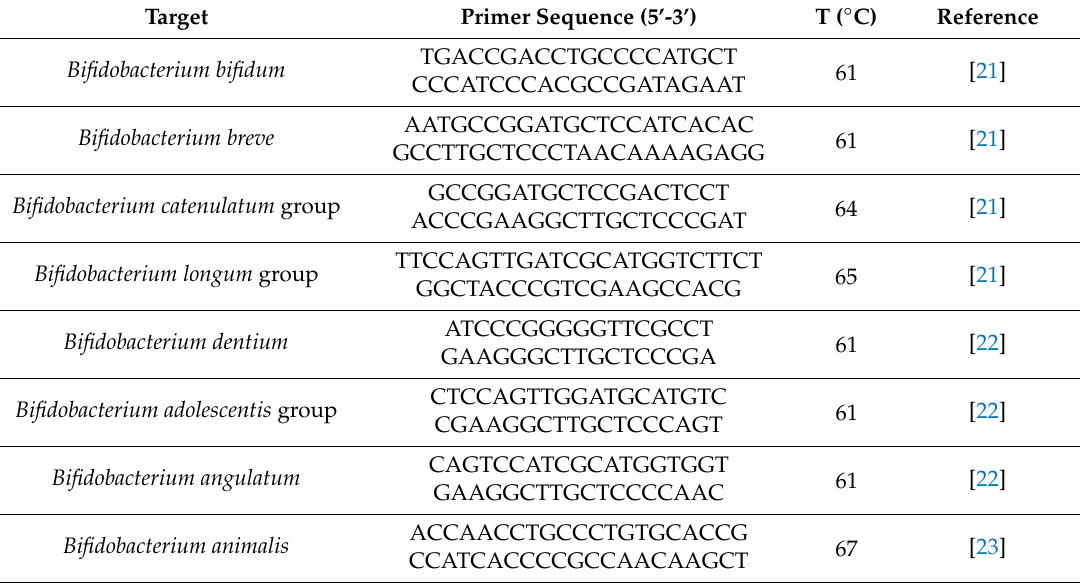
Table 1. Primers and annealing temperatures used in this study for Bifidobacterium species quantification by